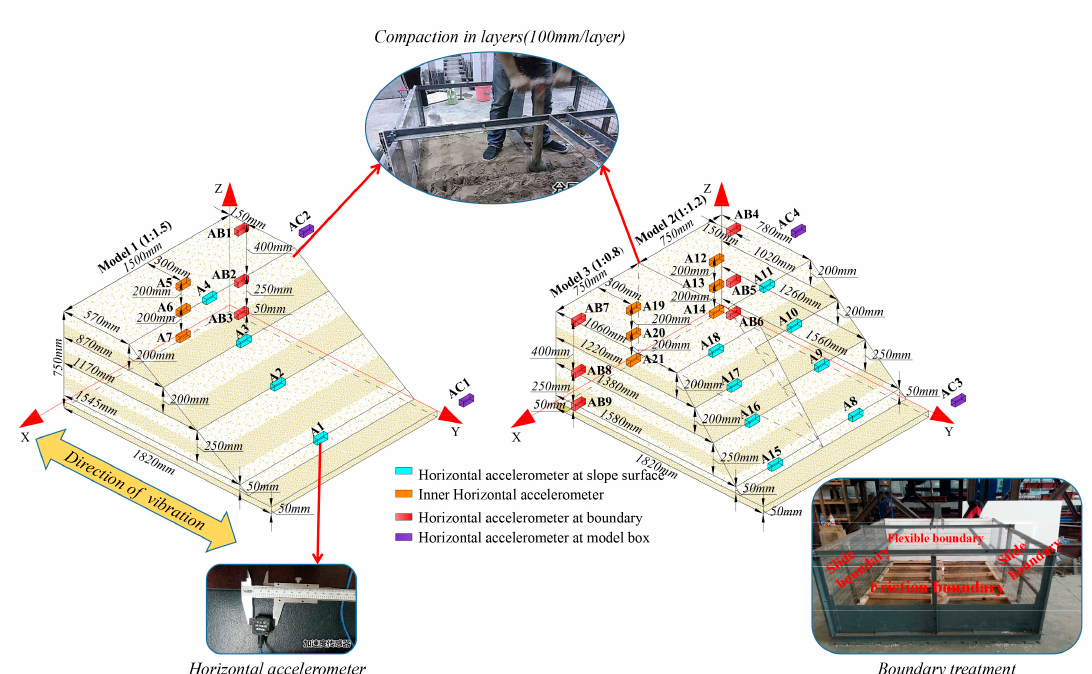
Figure 6. Embankment slope models and instruments layout.